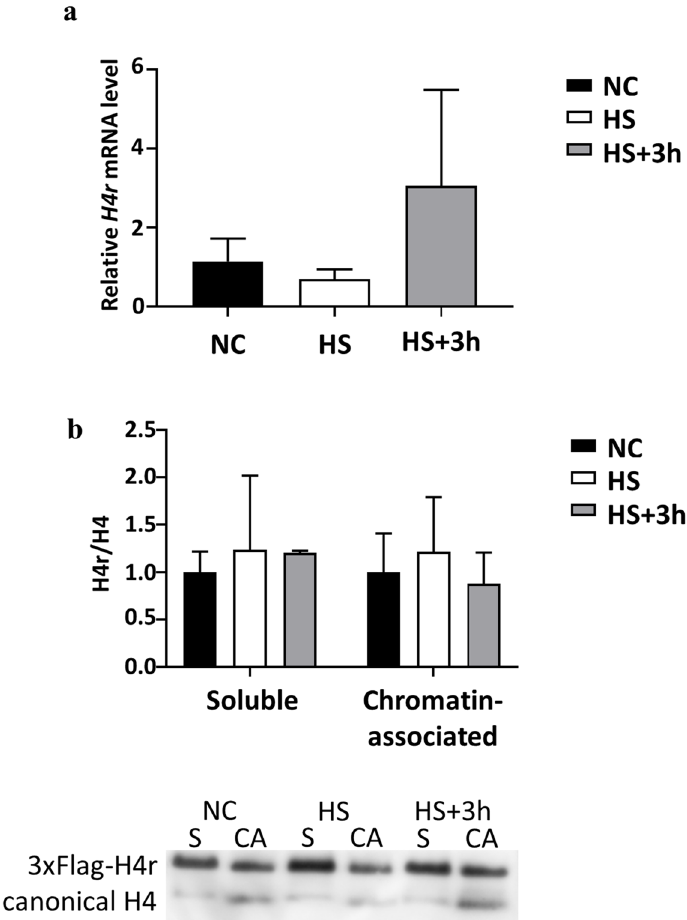
Figure 3. No significant changes can be detected in the expression and in the amount of H4r incorporated to chromatin upon heat shock and recovery. ( a ) Changes in the expression of H4r mRNA upon heat shock and recovery. (normalised to tubulin ; n = 2; p ≥ 0.1357; one-way ANOVA.); ( b ) Changes in the amount of soluble and chromatin associated H4r upon heat shock and recovery. NC: negative control; HS: heat shocked; HS + 3 h: heat shocked and relaxed (at room temperature) for three hours. S: soluble, CA: chromatin associated (n = 2; p ≥ 0.7529, one-way ANOVA. Error bars represent